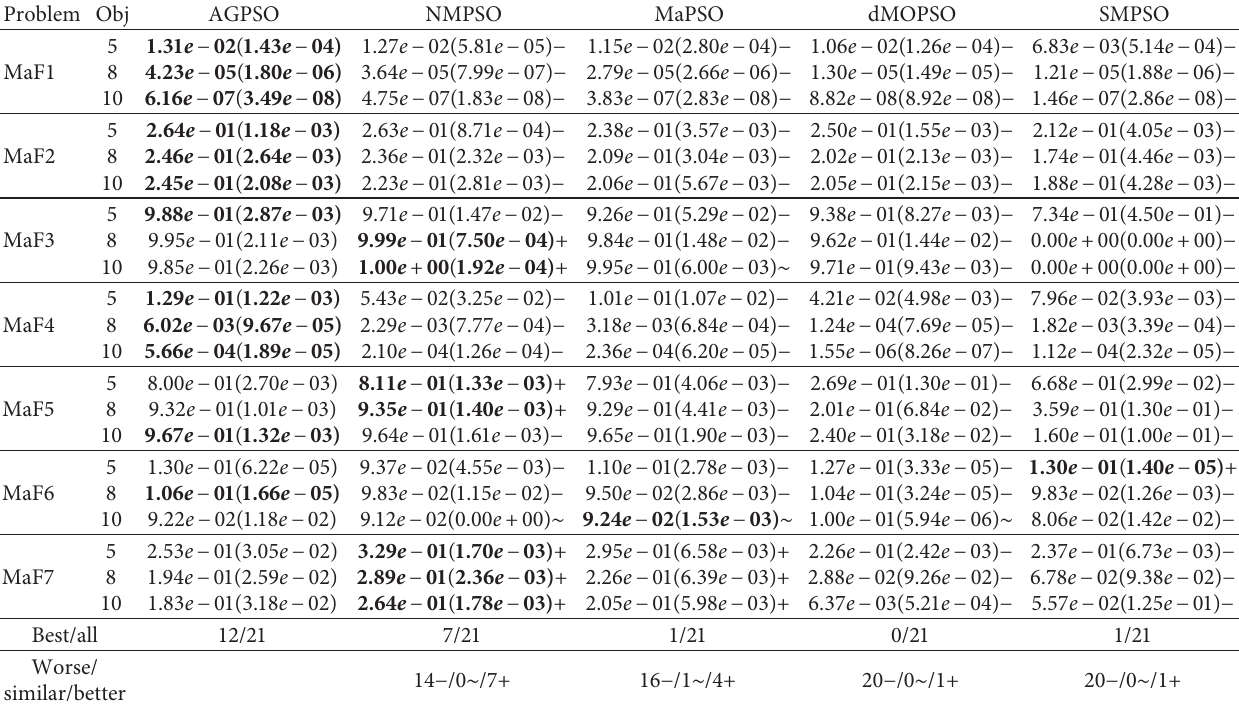
Table 3: Comparison of results of NMPSO and four current MOPSOs on MAF1-MAF7 using